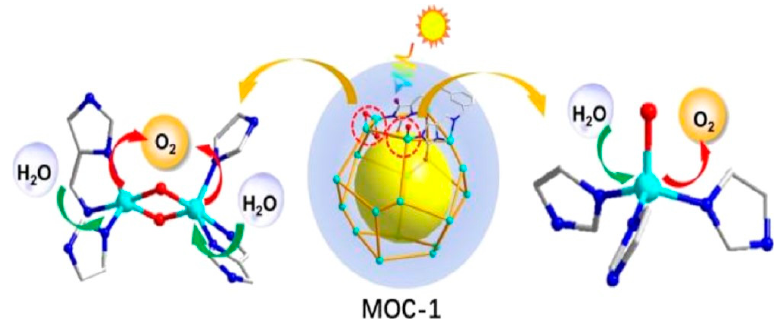
Figure 12. A Co MOC for photo-driven water oxidation. Reprinted with permission from (Chen et al., 2021) [89]. Copyright 2021 American Chemical Society.